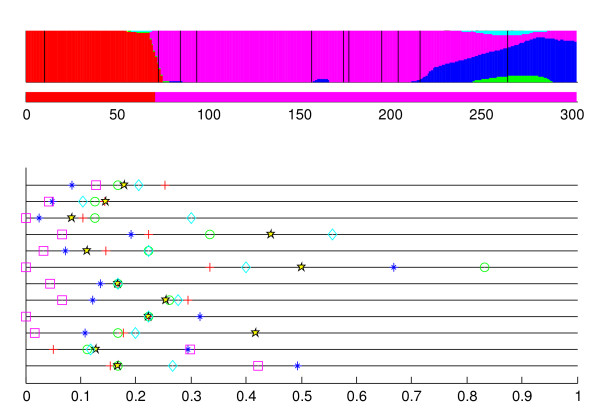
Coalescent strain #27. The results for strain #27 in the coalescent simulation. The results obtained from a recombination analysis with BRAT are shown in two colored plots in the upper part of the figure, a narrow plot below a wider plot. In these plots, the different colors correspond to the clusters obtained in the unsupervised mixture classification analysis. The x-axis position specifies a site in the analyzed gene. The narrow plot (optimal model profile) displays the detected optimal model, where each base is assigned to an origin specified by the optimal model. The wider plot (marginal probability profile) shows graphically for each site j in the sequence the marginal posterior probability distribution for Xj, j = 1, ..., ng, the origin of the jth base in the gene. The true breakpoint locations are shown by vertical black lines in the marginal probability profile. The plot in the lower part of the figure reflects the correct solution and shows fragmentwise molecular distances from this strain to the identified clusters. Horizontal lines correspond linearly to the different fragments, such that the lowest horizontal line corresponds to the first fragment, etc. The clusters are represented by cluster-specific colored markers. The distance of the marker from the Y-axis shows the average distance between the corresponding cluster and the strain in the corresponding fragment. The distances are normalized according to the lengths of the gene fragments.